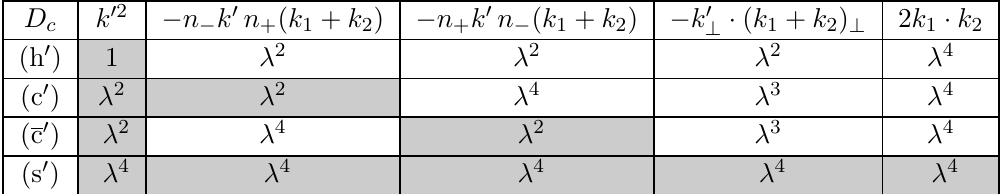
Table 4 . Scaling associated with the terms in the propagators D c , as de(cid:12)ned in eq. (2.22). The scaling of the various component in the di(cid:11)erent regions is provided in tables 3 and 4. Notice that we label the new regions with a prime, to distinguish them from the regions considered with the previous